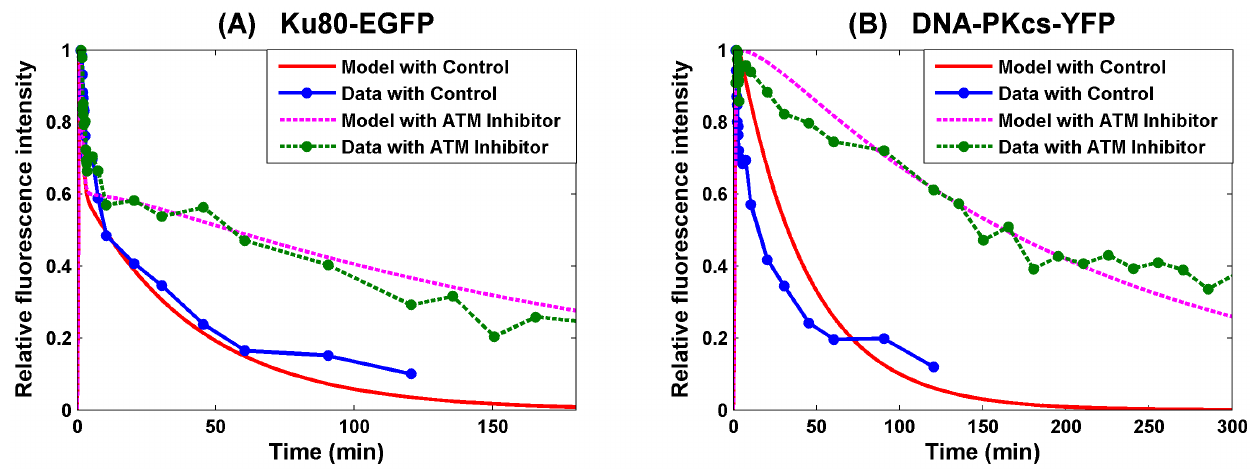
Figure 7. BF Model – Break Filling. Panel (A) is for Ku80-EGFP and panel (B) for DNA-PKcs-YFP. The lines with dots are experimental data from [1], and those without dots are numerical simulation of the model. The solid lines represent calculated normalized fluorescence intensity of the respective fluorescently tagged proteins with control, and the dashed lines are with ATM inhibitor present.